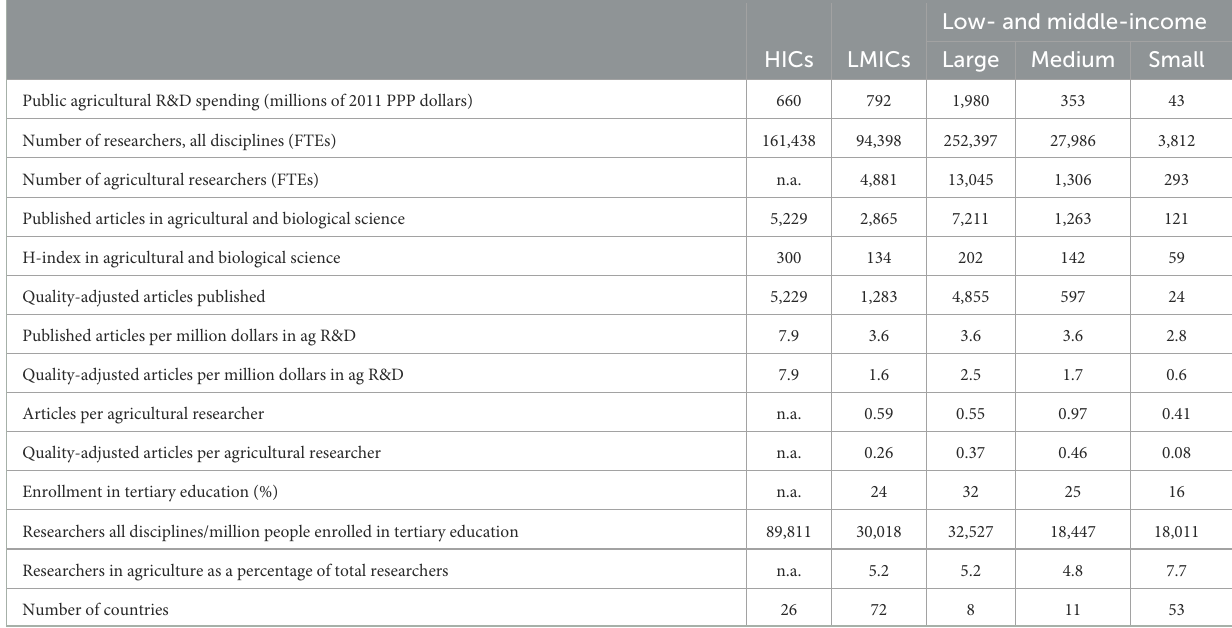
TABLE 4 Agricultural R&D input and output indicators of HICs and LMICs grouped by the size of their research systems, 2011–2016.